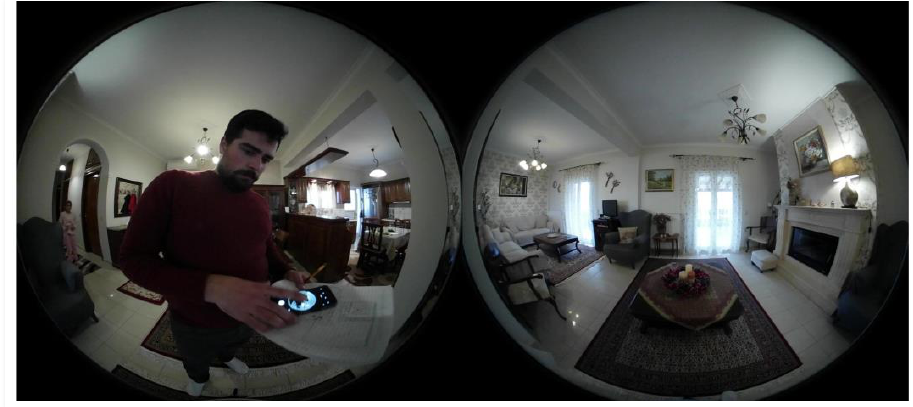
Figure 16. Production phase: while shooting.